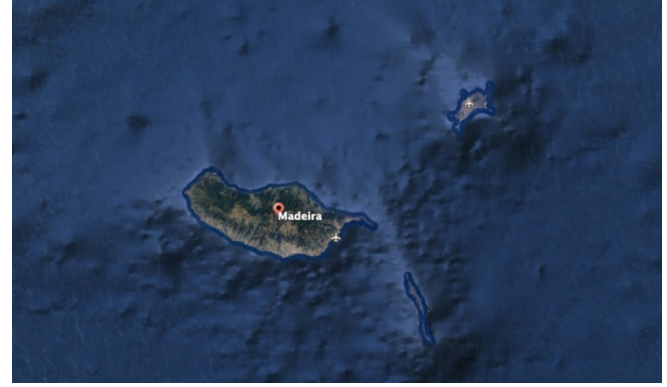
Figure 2. Macaronesia Region: The Azores.